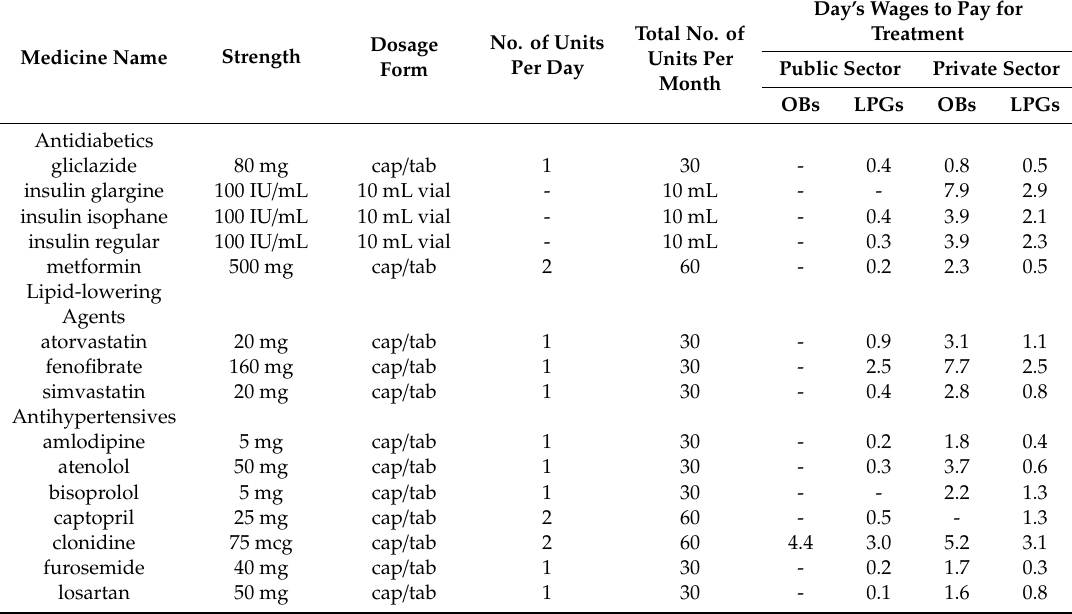
Table 3. A ff ordability of standard treatments purchased by the lowest-paid government